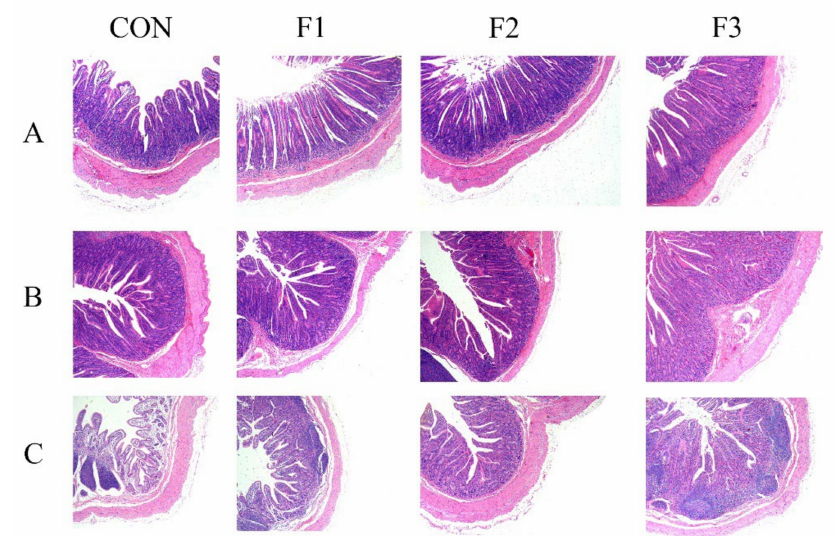
Figure 3. Micrograph of duodenum, jejunum and ileum supplemented with fucoidan in the diet of weaned kids: ( A ) duodenum; ( B ) jejunum; ( C ) ileum. F1, basal diet +0.1% fucoidan; F2, basal +0.3% fucoidan; F3, basal +0.5%